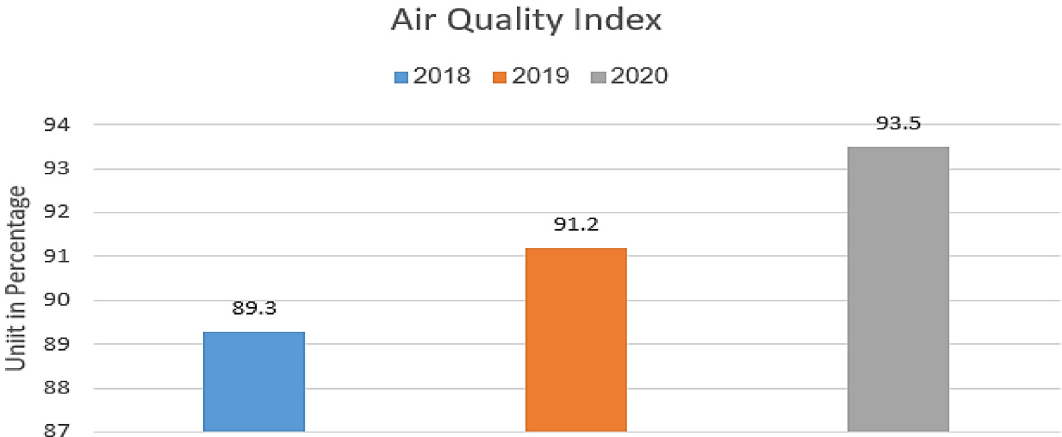
Fig. 9. Air quality index calculated and compared for 2018, 2019 and